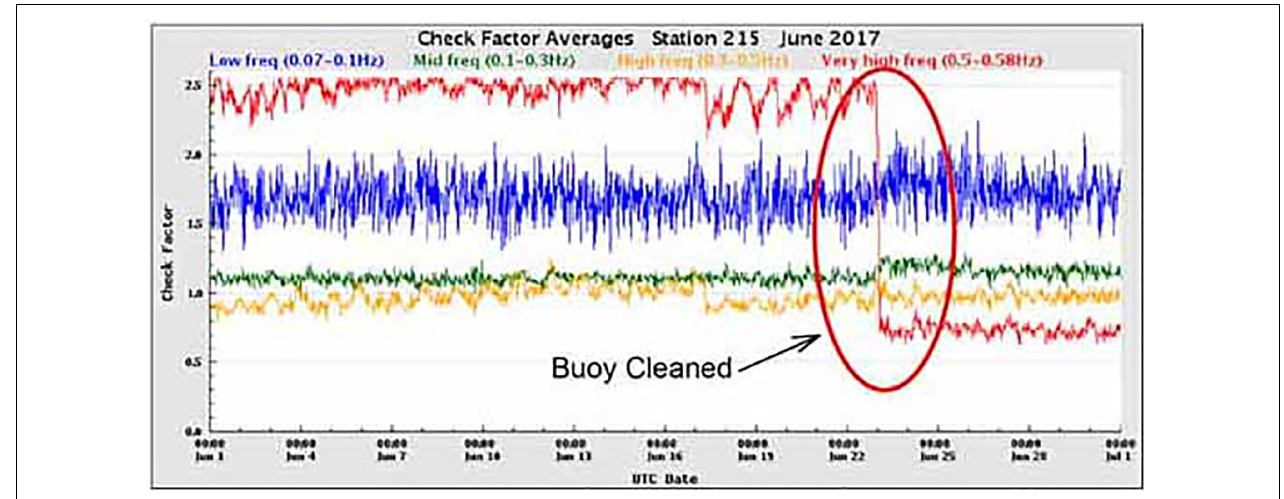
FIGURE 10 | The check factor indicated biofouling on the Long Beach Channel Buoy. As a result, divers cleaned the buoy and mooring line, returning the check factor to a normal